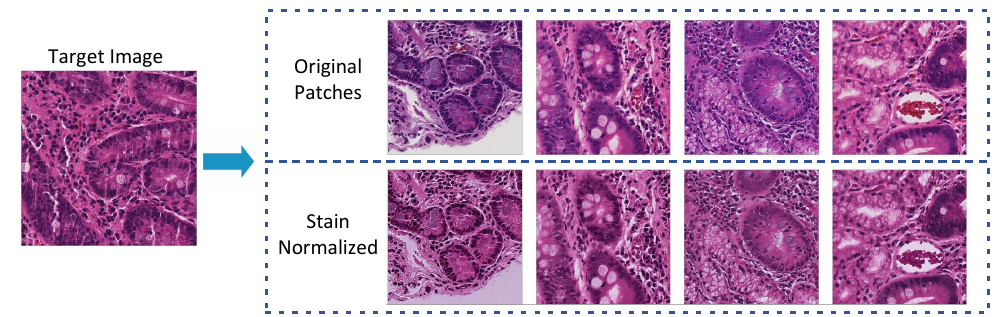
Figure 6. Stain normalization results when using the method proposed by Vahadane et al. [42]. Images in the first row represent the source images. The source images are normalized images to the stain appearance of the target image in second row